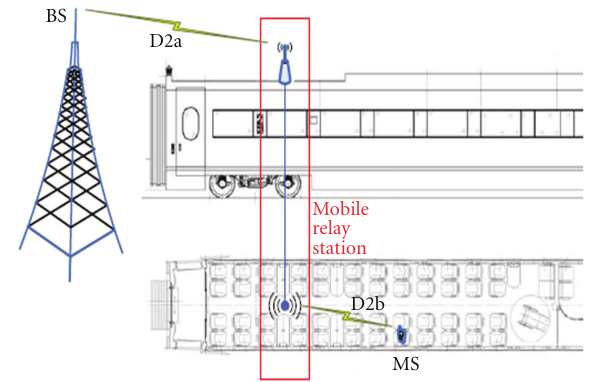
Figure 7: Relay transmission scenario in